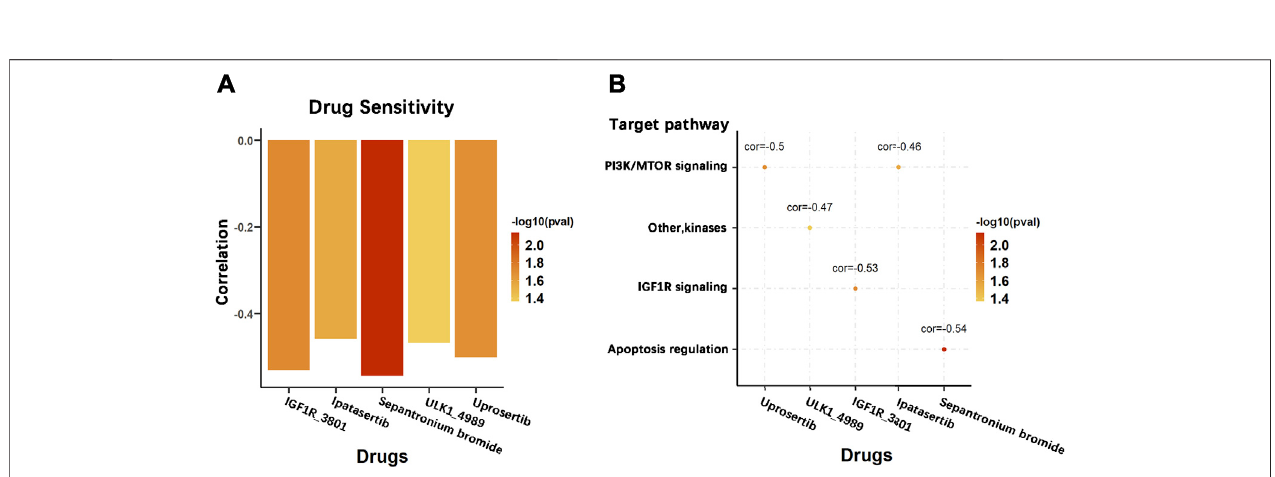
FIGURE 8 | Potential therapeutic value of the DRGS score in chemotherapy. (A) Pearson correlation analysis was used to calculate the correlation between the sensitivity level of different chemotherapeutic agents and the DRGS score of 23 types of gastric cancer cells; (B) Signalling pathways targeted by the drugs that are correlated with the DRGS